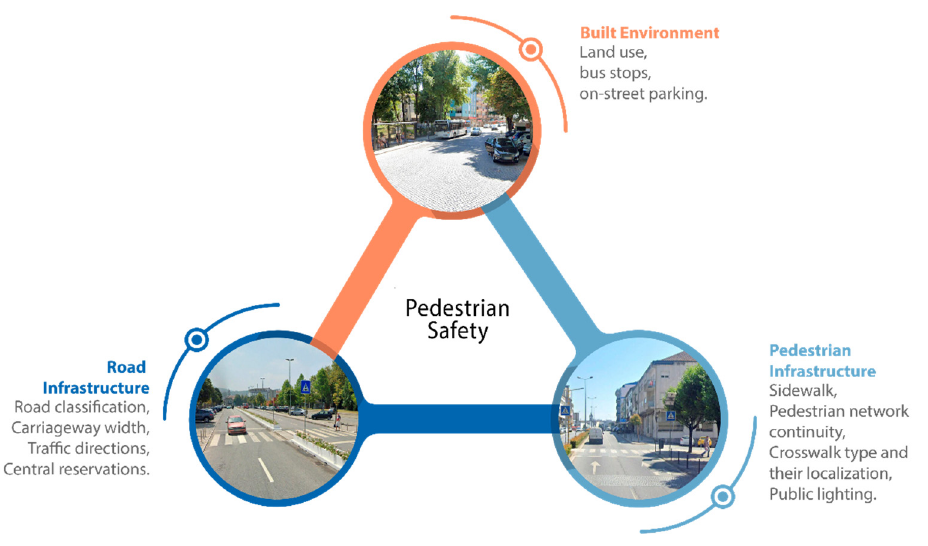
Figure 1. Factors influencing pedestrian safety.